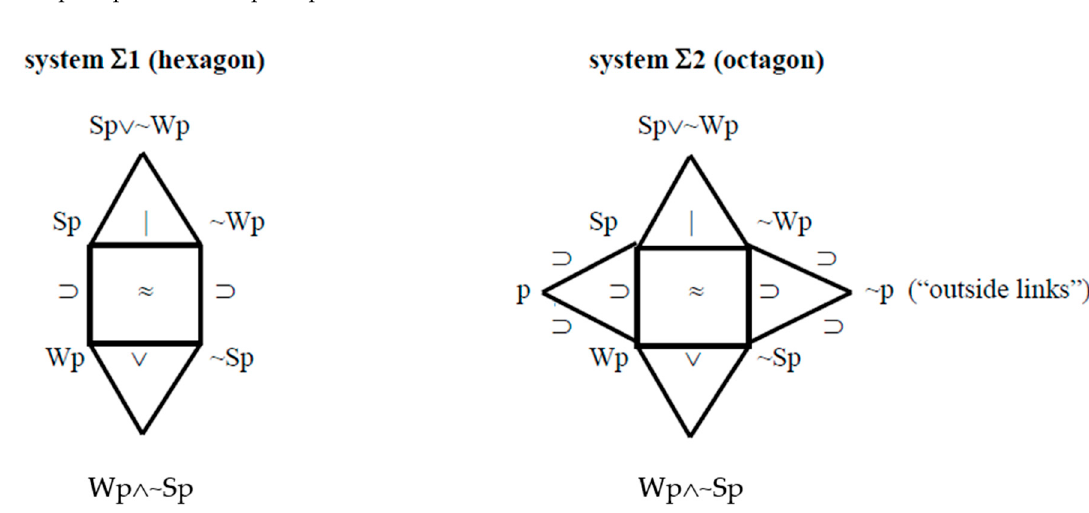
Figure 2. System Σ 1 and System Σ 2.